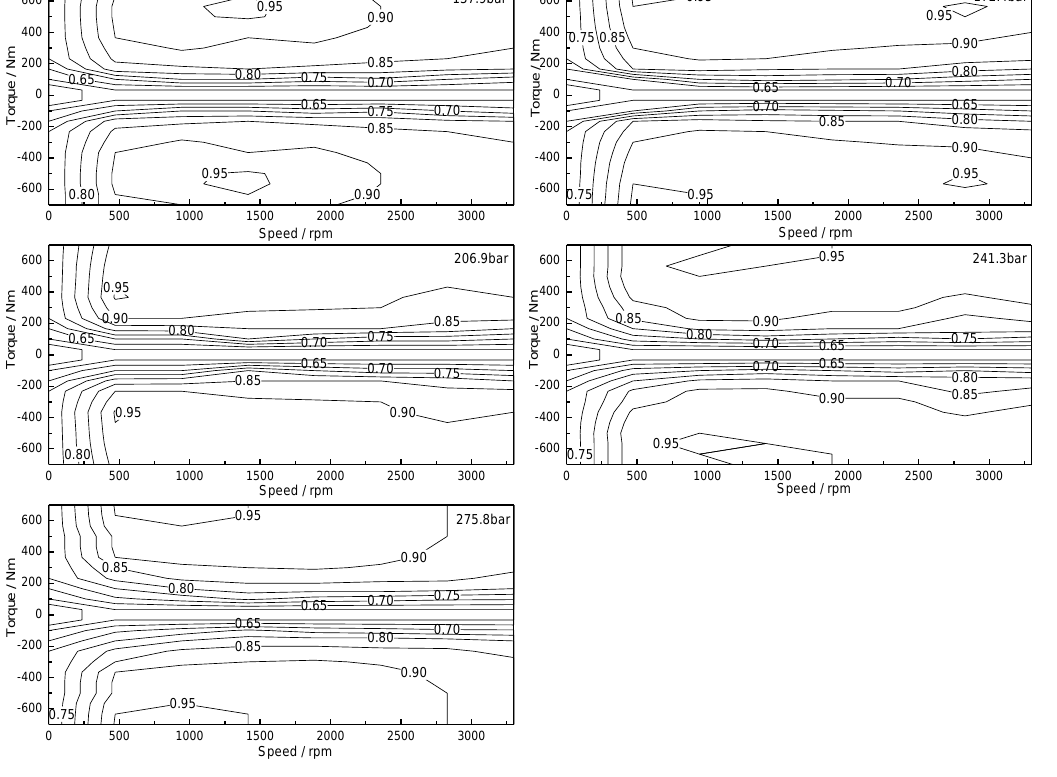
Figure 7. Efficiency contour diagrams for a 222-kW hydraulic P/M at different pressures.